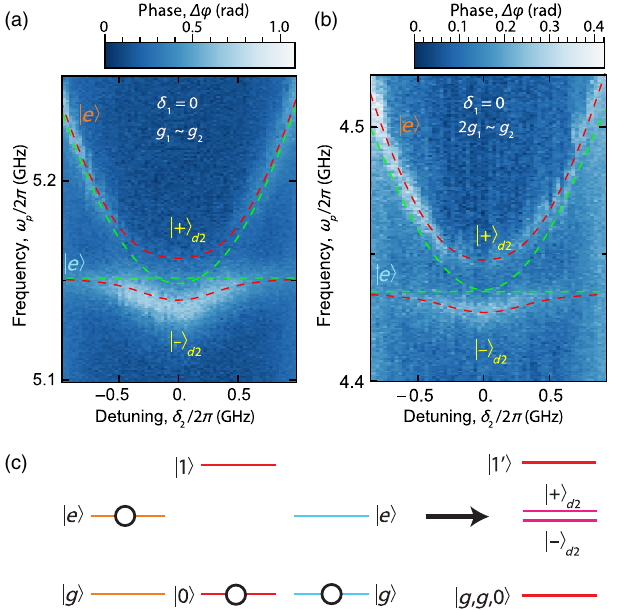
FIG. 3. Qubit spectroscopy of thevirtual photon-mediated qubit- qubit exchange interaction. (a) Resonator phase shift Δ φ for DQDs with equal coupling ( g 1 ∼ g 2 ) at fixed 2 t 1 = 2 π ¼ 5 . 156 GHz, δ 0 , and 2 t 2 π ¼ 5 . 148 GHz vs detuning parameter δ 1 ¼ 2 = Line traces and additional data are in Appendix G. (b) Qubit spectroscopy for DQDs with different coupling ( 2 g 1 ∼ g 2 ) and ω = 2 π ð δ 1 ¼ 0 Þ ¼ 4 . 436 GHz measuring the phase shift Δ φ of DQD 1 theresonatorvs δ 2 for 2 t 2 = 2 π ¼ 4 . 443 GHz.(c)Schematicenergy- level diagram of two DQDs in resonance and a detuned resonator. Basis states are shown on the left and hybridized states on the right with labels discussed in the text and in Appendix C.